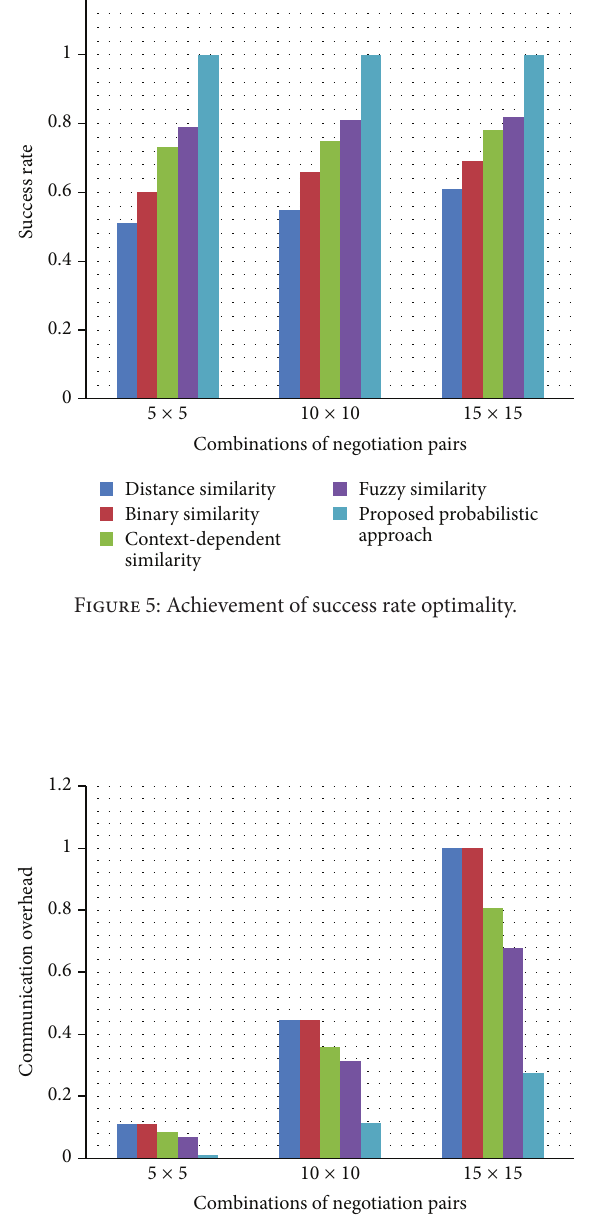
distributed parallel machine scheduling application needs to be improved with appropriate dynamic decision model in the preference of machines [29]. In order to support these future enhancements, the experimental data and related source code of the proposed cloud service negotiation framework are given in the